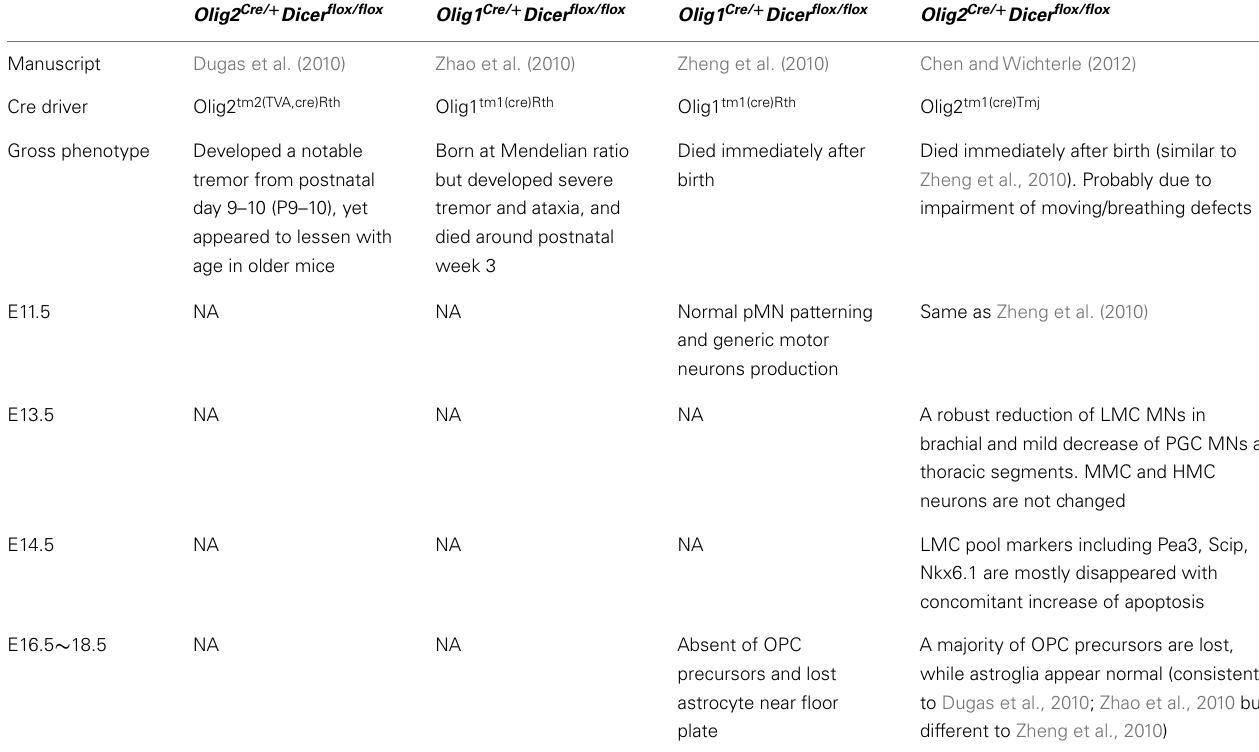
Table 1 | Comparison of genetic models disrupting miRNA biogenesis in spinal motor neurons. Olig2 Cre/ + Dicer